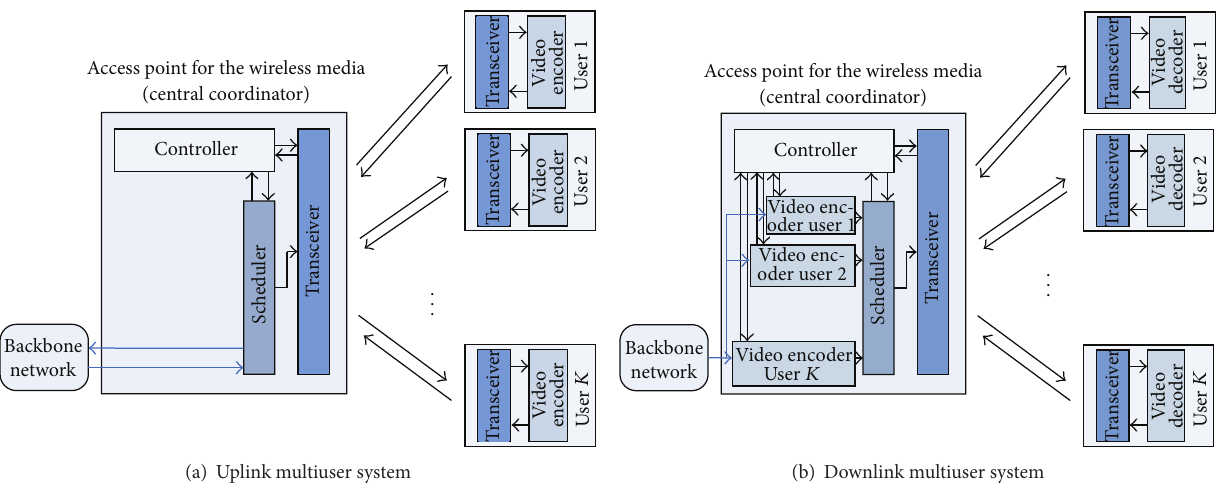
Figure 1: Multiuser video transmission systems of